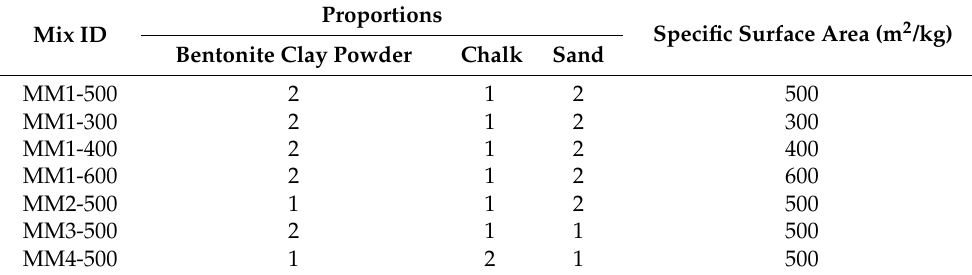
Table 2. Mix design of